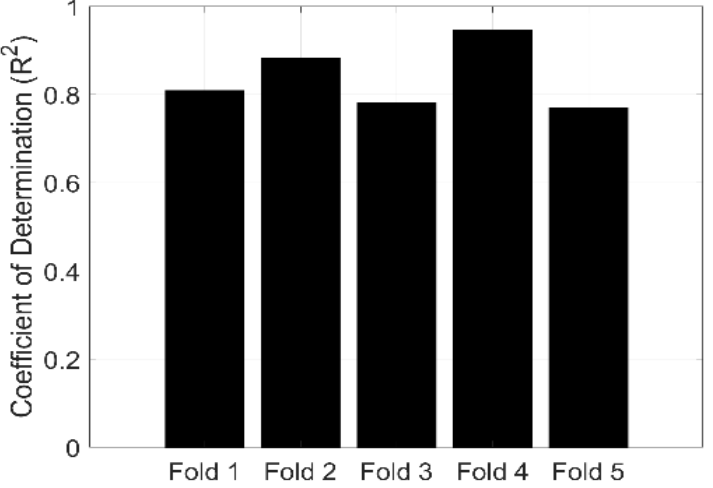
Figure 7. Comparison of model performance for different